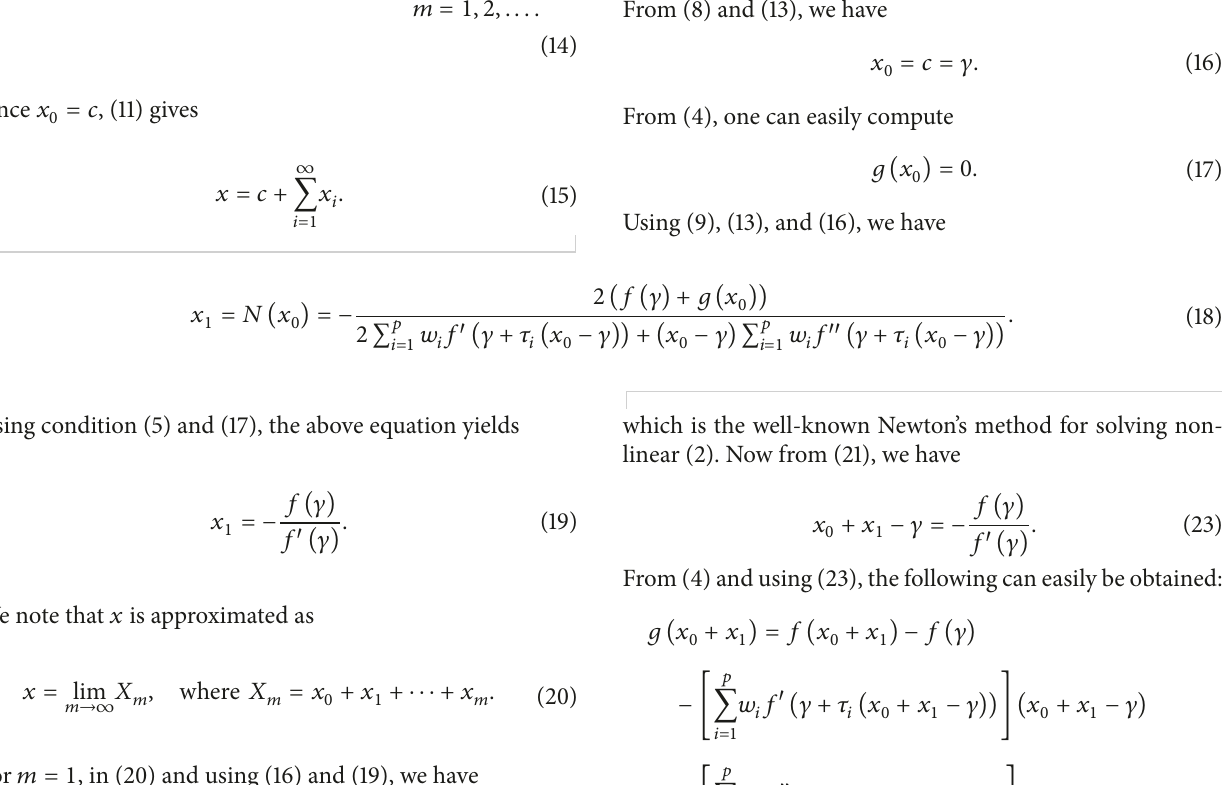
Algorithm 1. For a given 𝑥 0 , compute the approximate